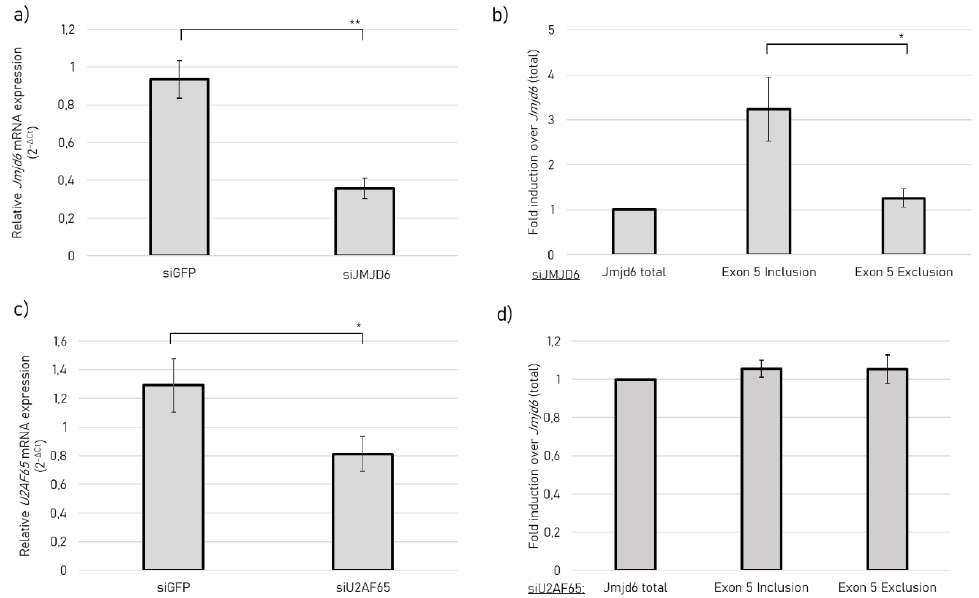
Figure 6. Exon 5 splicing at Jmjd6 locus. ( a ) Jmjd6 expression in HEK 293nT cells after transfection with siGFP (control) or siJmjd6 after RT-qPCR; Cyclophilin A was used as a reference gene for RT-qPCR to calculate relative jmjd6 mRNA expression after transfection; ( b ) Fold induction of Exon 5 inclusion and exclusion transcripts over jmjd6 after jmjd6 siRNA transfection, total jmjd6 was used as reference gene for RT-qPCR to calculate fold change expression of jmjd6-2 (Exon 5 exclusion) and jmjd6-Ex5 (Exon 5 inclusion). ( c ) U2af65 expression in HEK 293nT cells after transfection with siGFP (control) or siU2AF65. Cyclophilin A was used as a reference gene for RT-qPCR to calculate relative